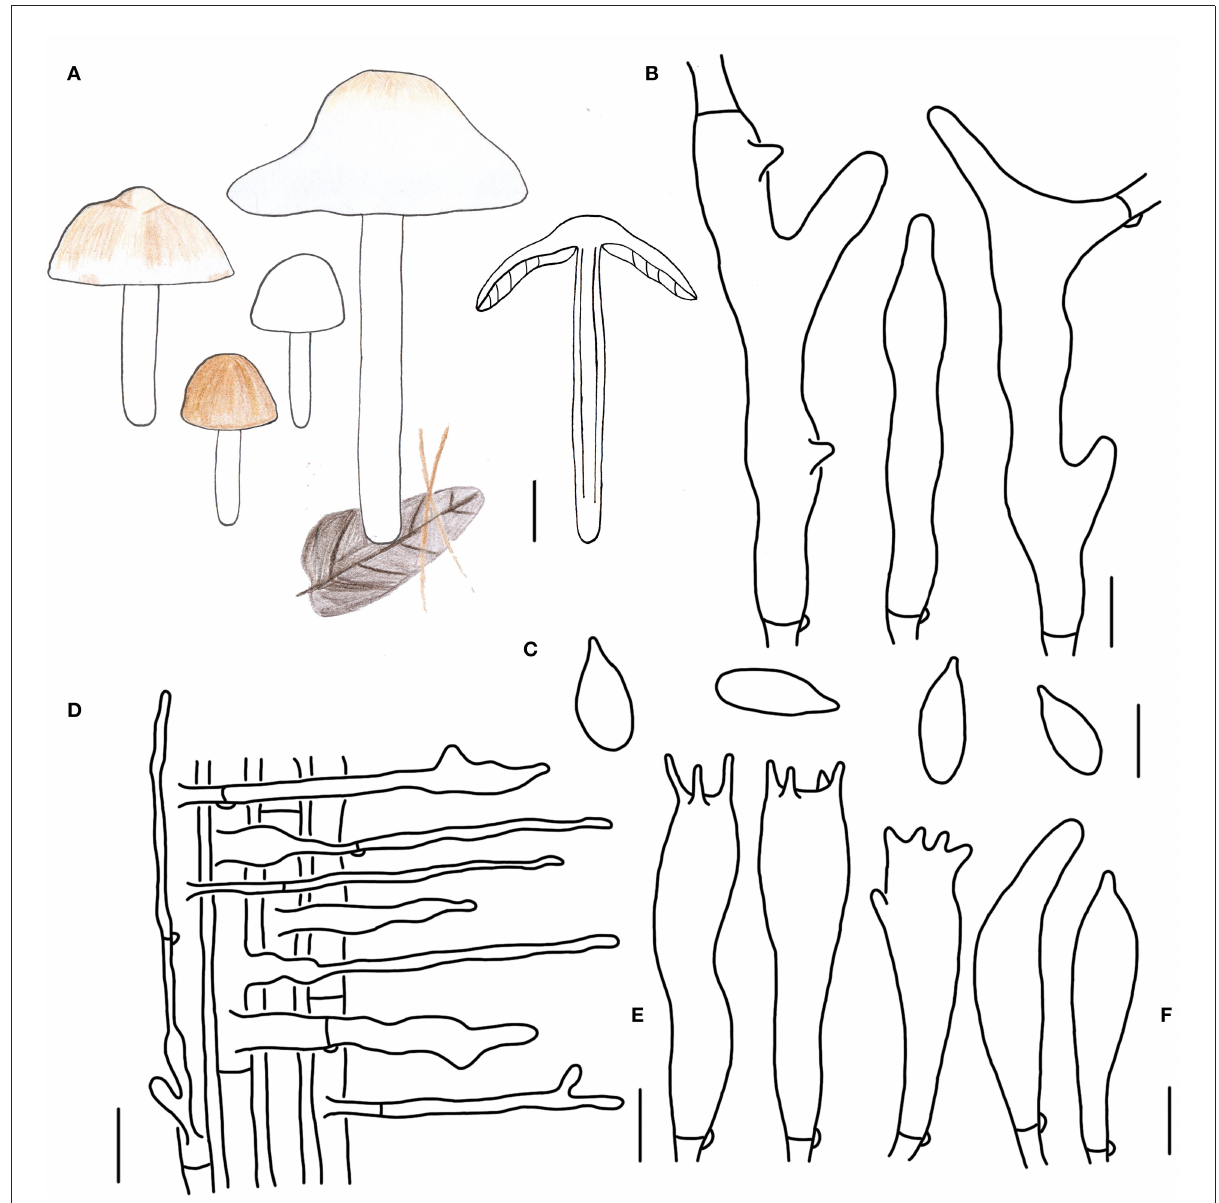
FIGURE7 Morphological characteristics of Gymnopus densilamellatus (HMJAU 61015). (A) Basidiomata; (B) Pileipellis elements; (C) Basidospores; (D) Caulocystidia; (E) Basidia; (F) Cheilocystidia; Scale bars: 2cm (A) ; 10 µ m (B) ; 5 µ m (C,E,F) ; 20 µ m (D) .